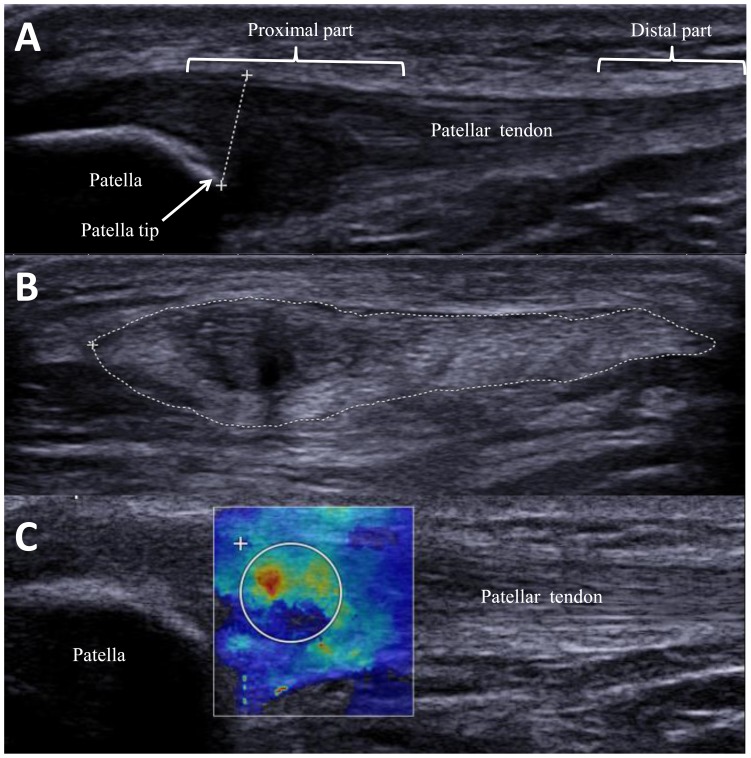
Sonography images of the patellar tendon (A) Thickness of the patellar tendon (dotted line) was measured from the superior border of the patellar tendon to the tip of the patellar.(B) Cross-sectional area of the patellar tendon was measured by tracing the outer margin of the patellar tendon (dotted circle) (C) Shear elastic modulus of the patellar tendon was quantified by the elastography. The white circle delineates the area of interest.